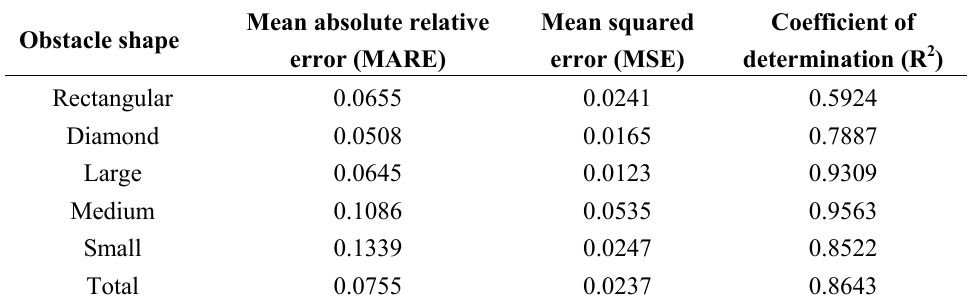
Table 11. Performance of the proposed model for variety of obstacles.